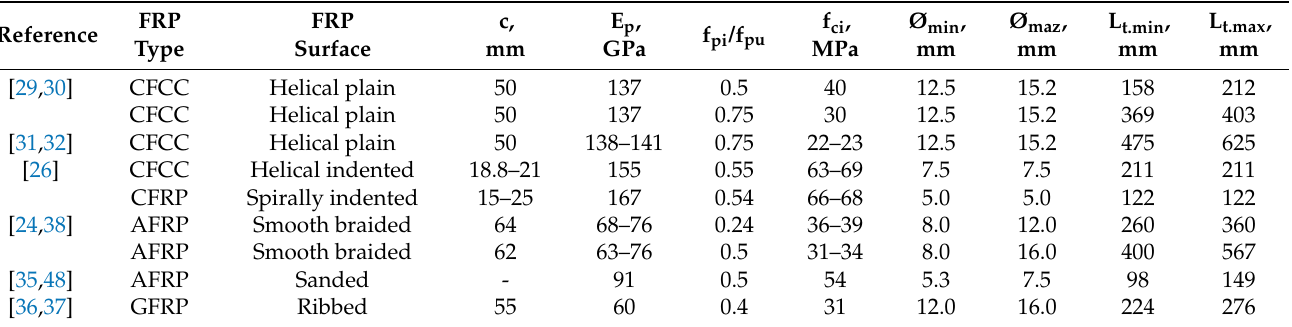
reinforcement diameters, respectively, L t.min and L t.max —lower and higher transfer lengths,